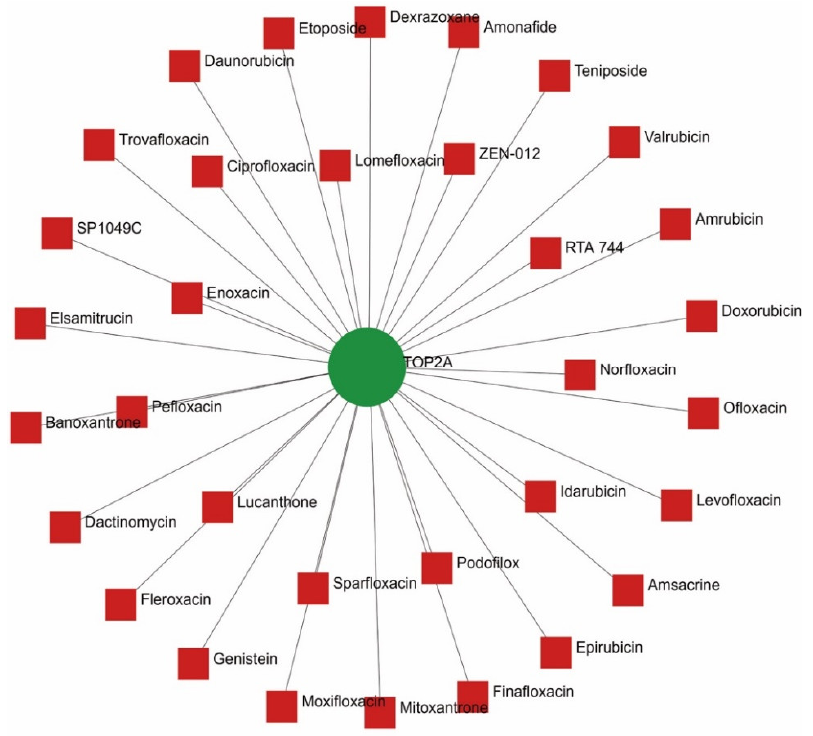
Figure 7. Drug–Hub gene interaction. The green circle represented the hub gene; the red squares represented the drugs. Table 3. Candidate drugs targeting hub genes .